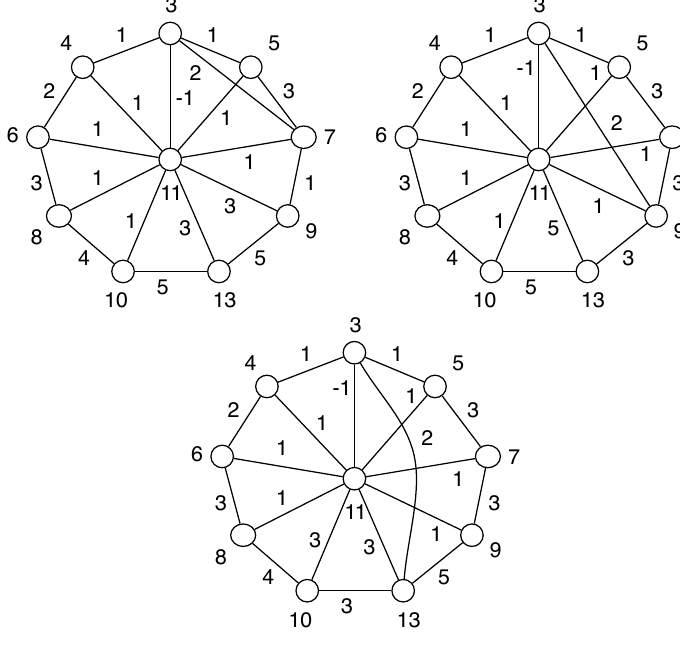
Figure 12: IAM( W +